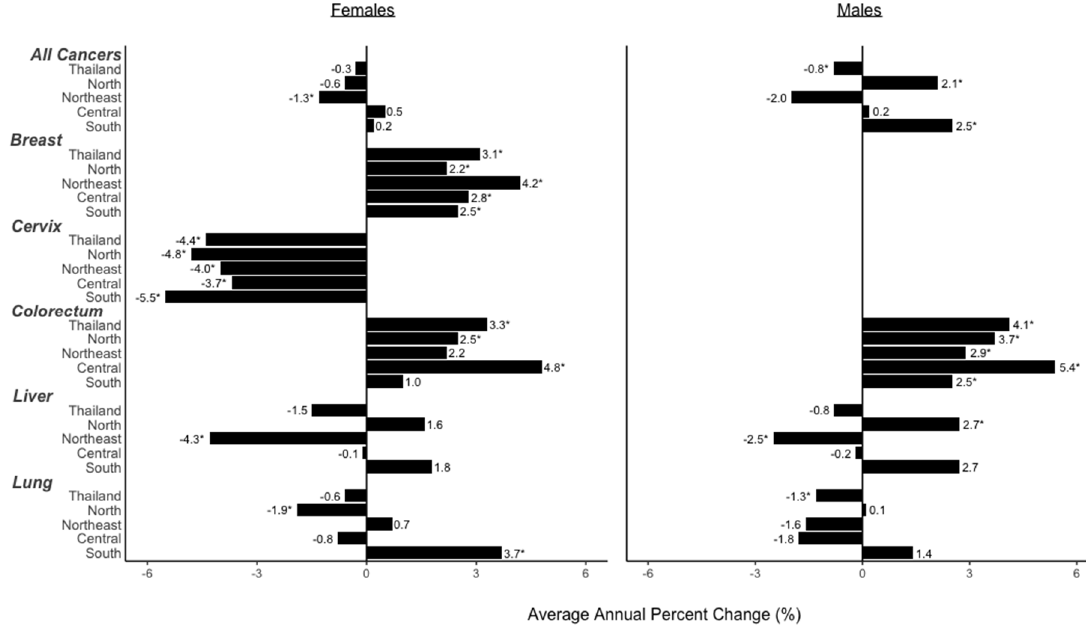
Figure 3. National and subnational average annual percent changes (AAPC) of each cancer from 2000 to 2012 for females and males. Significant AAPC are denoted with an asterisk (*). Significance was achieved at α = 0.05.